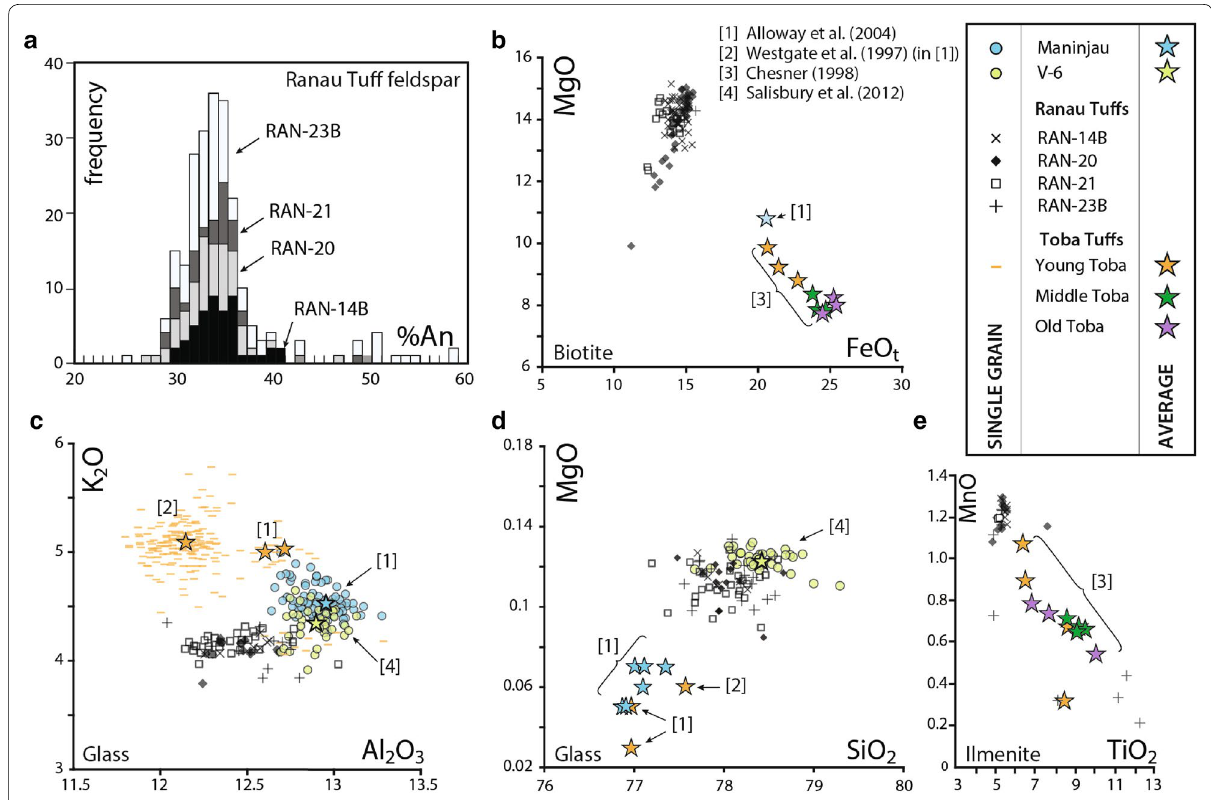
Fig. 10 Major element compositions supporting correlation of the Ranau Tuff outcrops over a distance of 100 km. a All Ranau Tuff samples are dominated by andesine feldspar. b Biotite compositions are similar for all analyzed Ranau Tuff samples, but differ significantly from tephras erupted from Toba (Westgate et al. 1997) and Maninjau calderas. c , d Glass compositions of all Ranau Tuff samples are similar. Of the Sumatran tuffs with available compositional data, the Ranau glass composition is most similar to that of the V-6 tephra of Salisbury et al. (2012) from offshore of South Sumatra. e Ilmenite compositions of all Ranau Tuff samples are similar; however, RAN-23B exhibits a wider range of compositions that suggests contamination of the very distal tephra by separate igneous sources, probably due to reworking of older material during